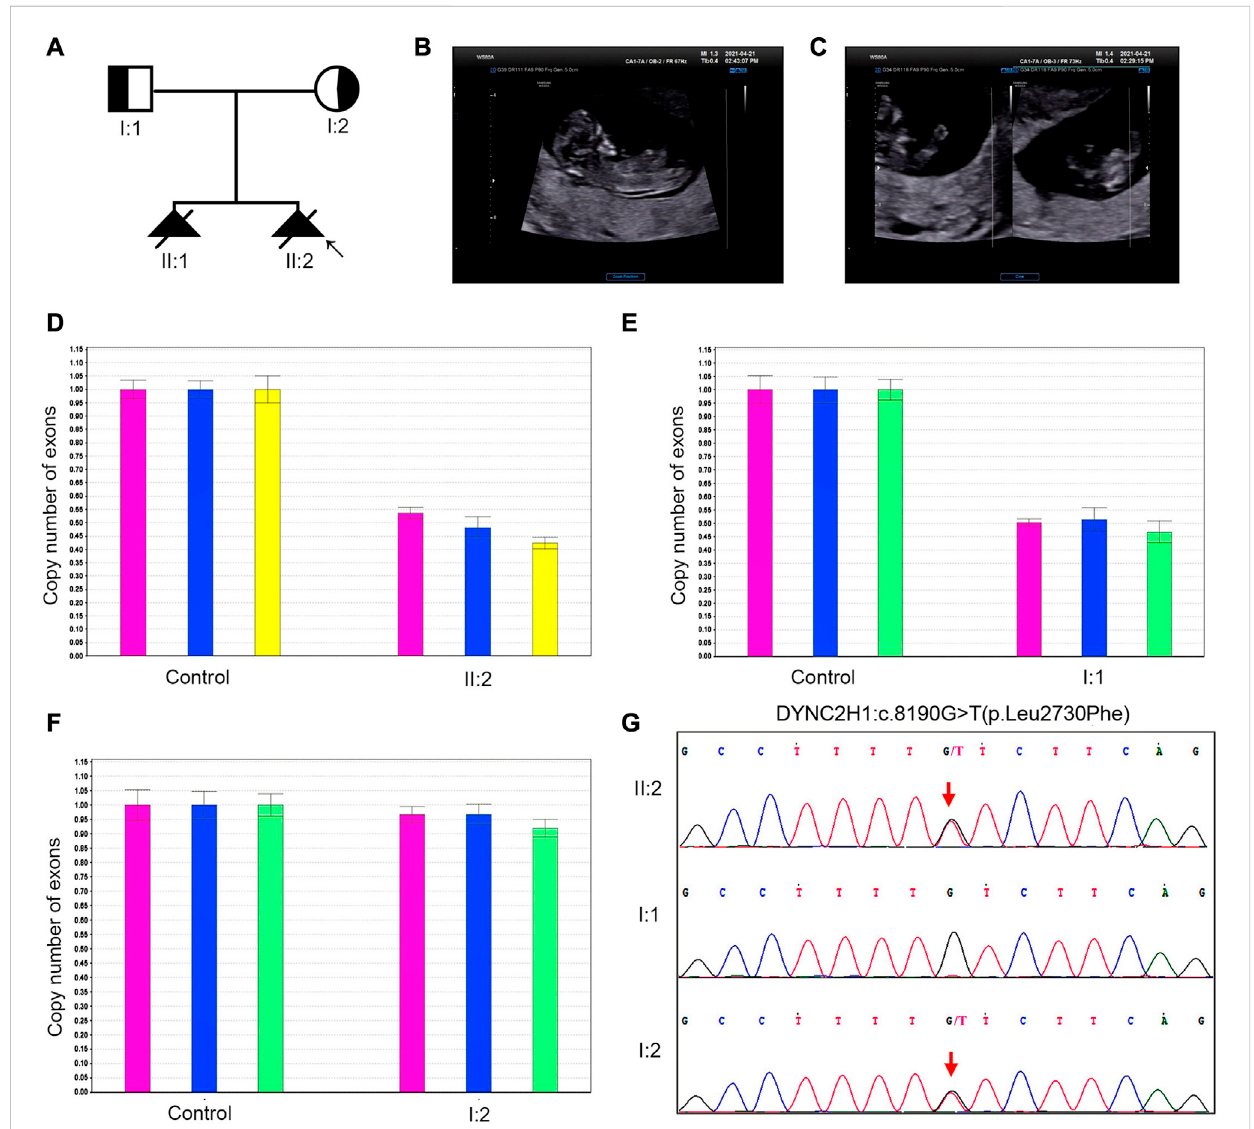
FIGURE 2 Theclinical fi ndingsandgeneticvariation incase2. (A) Pedigreediagramofthefamily withSTRD3. (B,C) Ultrasonographicindicationsofthefetusin case2:thefetushadextremelyshortlimbsandbowingoflongbones. (D – G) Thegeneticvariationidenti fi edincase2:proband2(II-2inCase2)carriedan exonic deletion and amissensevariant: exon (64 – 83)del and c.8190G > T (p.Leu2730Phe).qPCR validation con fi rmedone copylossofthe64-83exons in DYNC2H1 of proband 2 (D) . Validation with Sanger sequencing and qPCR demonstrated that the variants these probands carried were all inherited from their asymptomatic heterozygous carrier